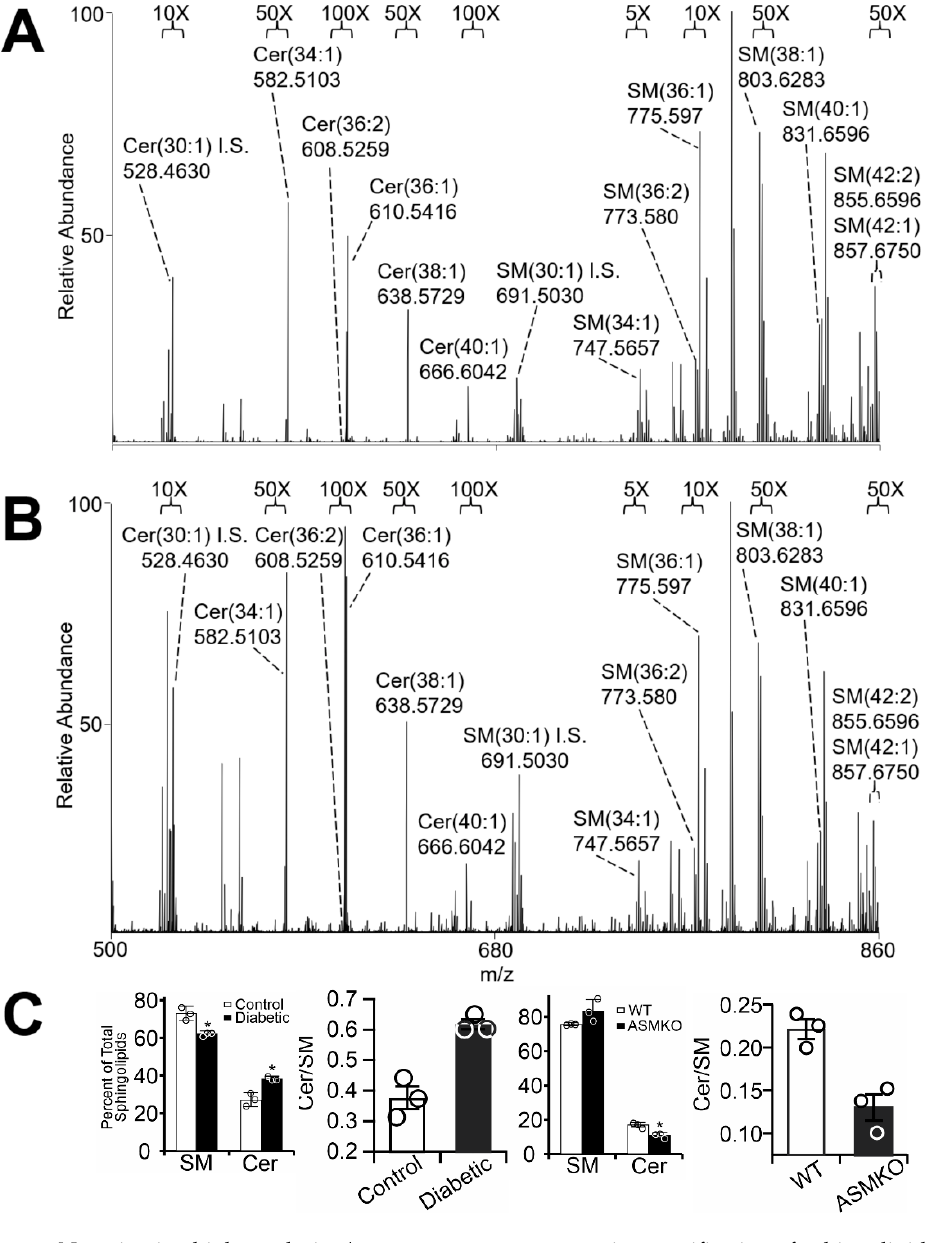
Figure 1. Negative-ion high-resolution/accurate mass spectrometric quantification of sphingolipids in retinal mitochondria. Mass spectra of control ( A ) and diabetic ( B ) rat retinal mitochondrial sphingolipids after 7 weeks of diabetes. Full-scan MS spectra are shown from mitochondrial lipids analyzed by negative-ionization mode direct-infusion nano-ESI mass spectrometry. Sphingolipids are shown under magnifications indicated at the top of each panel. Abundant non-labeled peaks correspond to phospholipids. “I.S.” indicates internal standards. ( C ) Quantification of total sphingomyelin (SM), ceramide (Cer), and the Cer/SM ratio based on mass spectrometry analysis of mitochondria from control and diabetic rat retinas ( left panel), and wild type (WT) and acid sphingomyelinase knock out (ASMKO) mouse retinas ( right panel). * p < 0.05, n = 3.